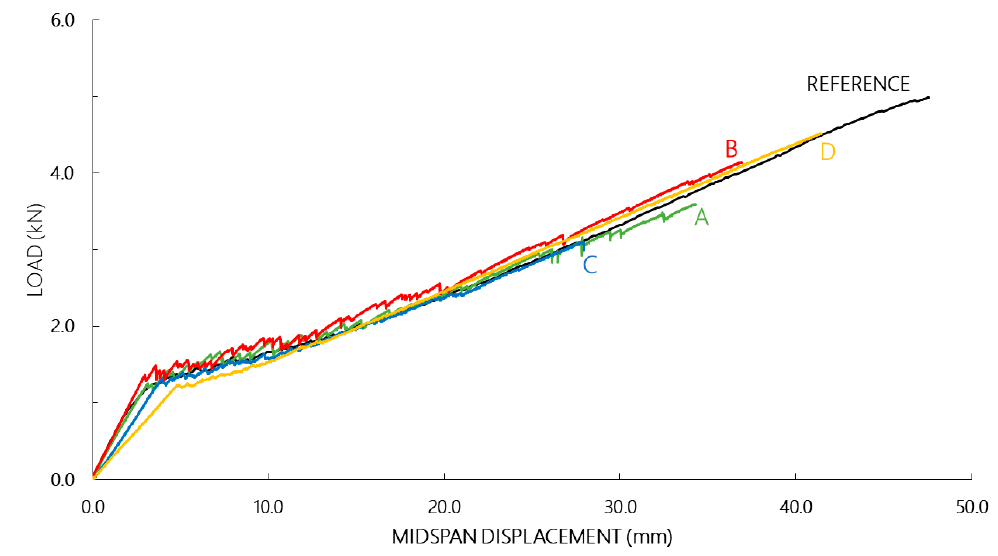
Figure 18. Residual behavior of SW CYCL. 2.0 MPa. Table 11. Quantitive comparison of some distinctive parameters of the static load-displacement curve: the average reference versus the beams cyclically preloaded to 2.0 MPa.